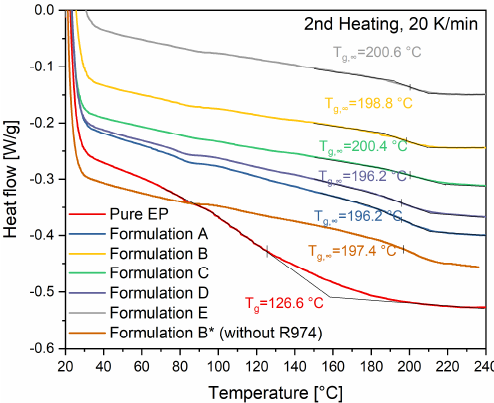
Figure 9. ( a ) The representative DSC dynamic measurement curves of formulations with the same filler content 55 wt.%, but different filler sizes ( b ) Influence of filler size on the glass transition temperature T g , the reaction peak temperature T peak and the enthalpy of reaction Δ H total of compounds.